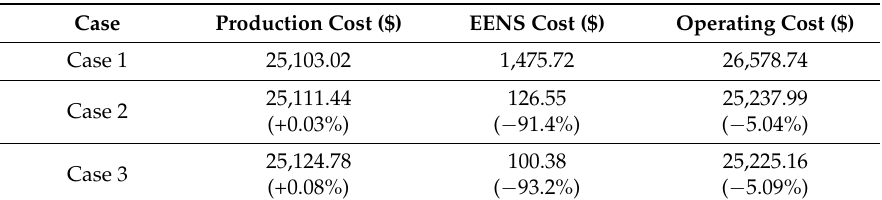
Table 8. The expected operating costs with